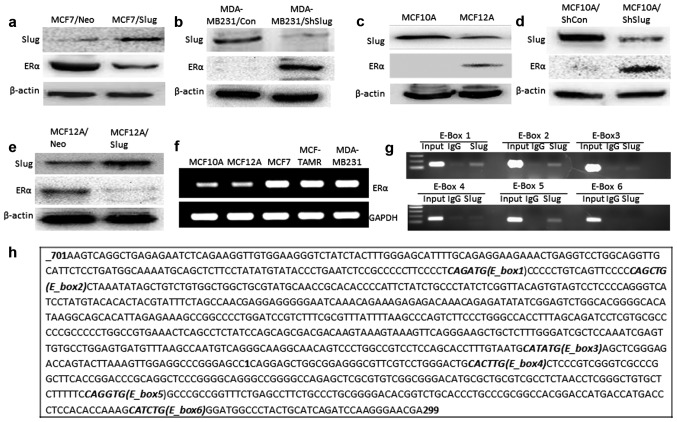
Slug downregulates ERα expression by binding to E-box on ERα promoter region. (a–e) ERα and Slug expression in normal breast cell lines MCF12A and MCF10A, MCF7, transient MCF12A/Slug, transient MCF10A/ShSlug, transient MCF7/Slug and transient MDA-MB-231/ShSlug cell lines. Total protein was extracted using Thermo protein RIPA buffer, and 50 μg protein for each sample was used for immunoblot analysis. (f) Genomic ERα expression comparison by RT-PCR in MCF10A, MCF12A, MCF7, MCF-TAMR and MDA-MB-231 lines. (g) Chromatin immunoprecipitation assays identified Slug binding sites within the proximal promoter region of ERα gene. PCR reaction products from input control DNA, IgG antibody control and Slug antibody pull-down. (h) Sequence of ERα promoter region contains six E-Boxes as indicated.